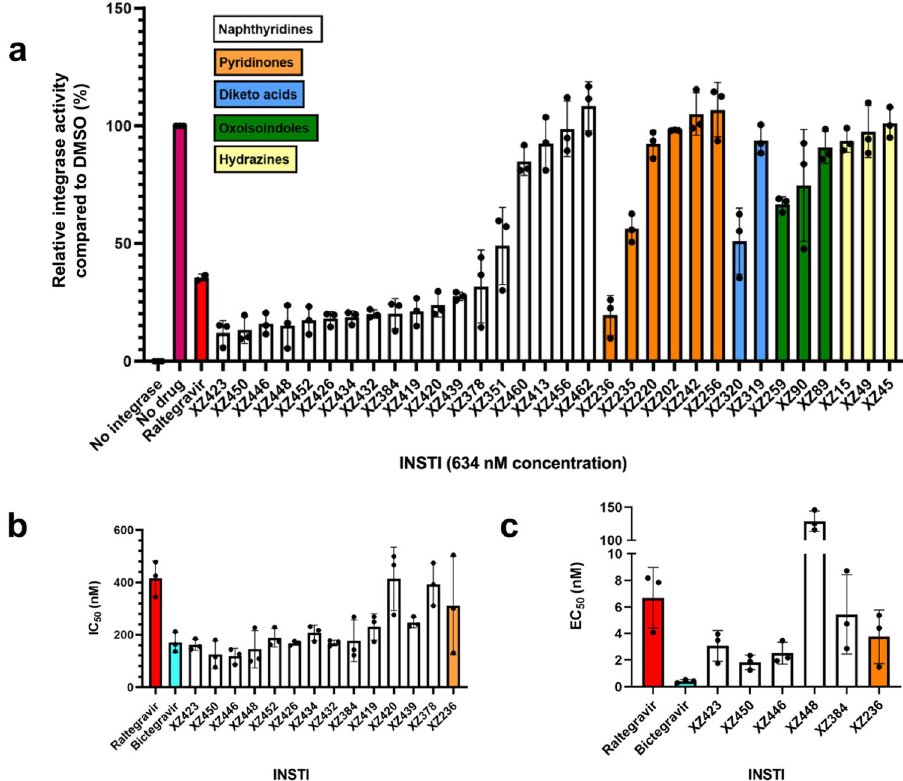
Fig. 1 Sensitivity of HTLV-1 integrase to different classes of integrase strand transfer inhibitors (INSTIs) in vitro. a Screening of HTLV-1 IN strand transfer activity in presence of a panel of INSTIs at 634 nM. Results are shown from high to low inhibition activity within each colour-coded INSTI class. Percent inhibition compared with WT HTLV-1 IN in the presence of a vehicle is shown. b IC 50 values were determined for the most promising INSTIs from the naphthyridine and pyridinone classes and compared with previously obtained raltegravir (RAL) and bictegravir (BIC) values 9 . c EC 50 values for INSTIs tested in the MT-2 – Jurkat cell-to-cell infection model and compared with previously reported RAL and BIC values 9 . Individual data points, mean values and standard deviations of n = three biologically independent experiments are shown. Exact IC 50 and EC 50 values are contained in Supplementary Figs. 4 and 5 and Supplementary Table 2. Source data are provided as a Source Data